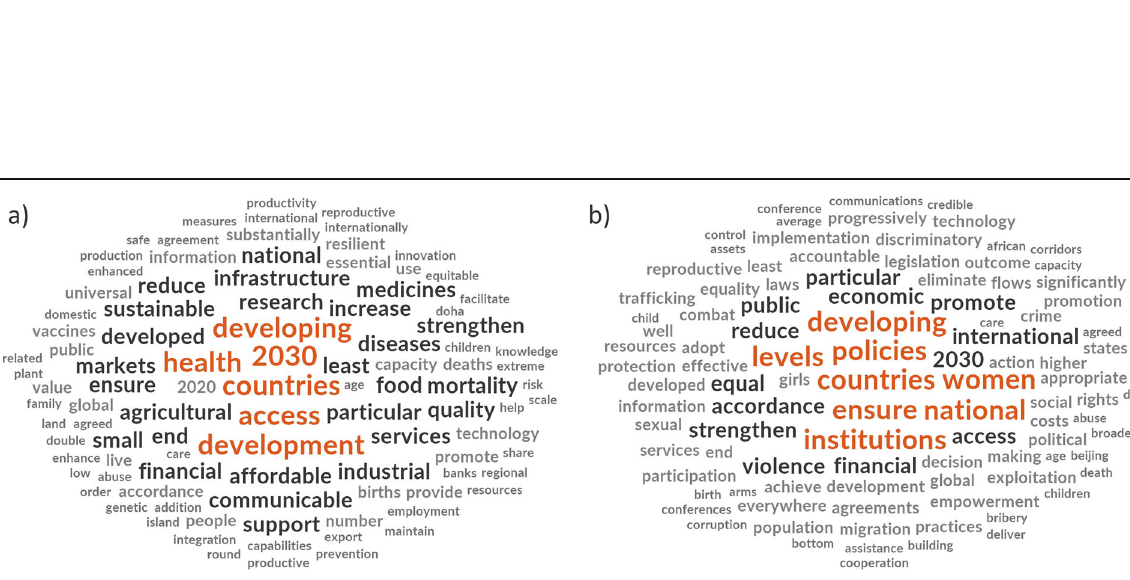
Fig. 12 Word clouds generated for a) the three SDGs with the most (SDG 2, 3, and 9) and b) the three SDGs with the fewest project alignments (SDGs 5, 10, and 16), using NVivo